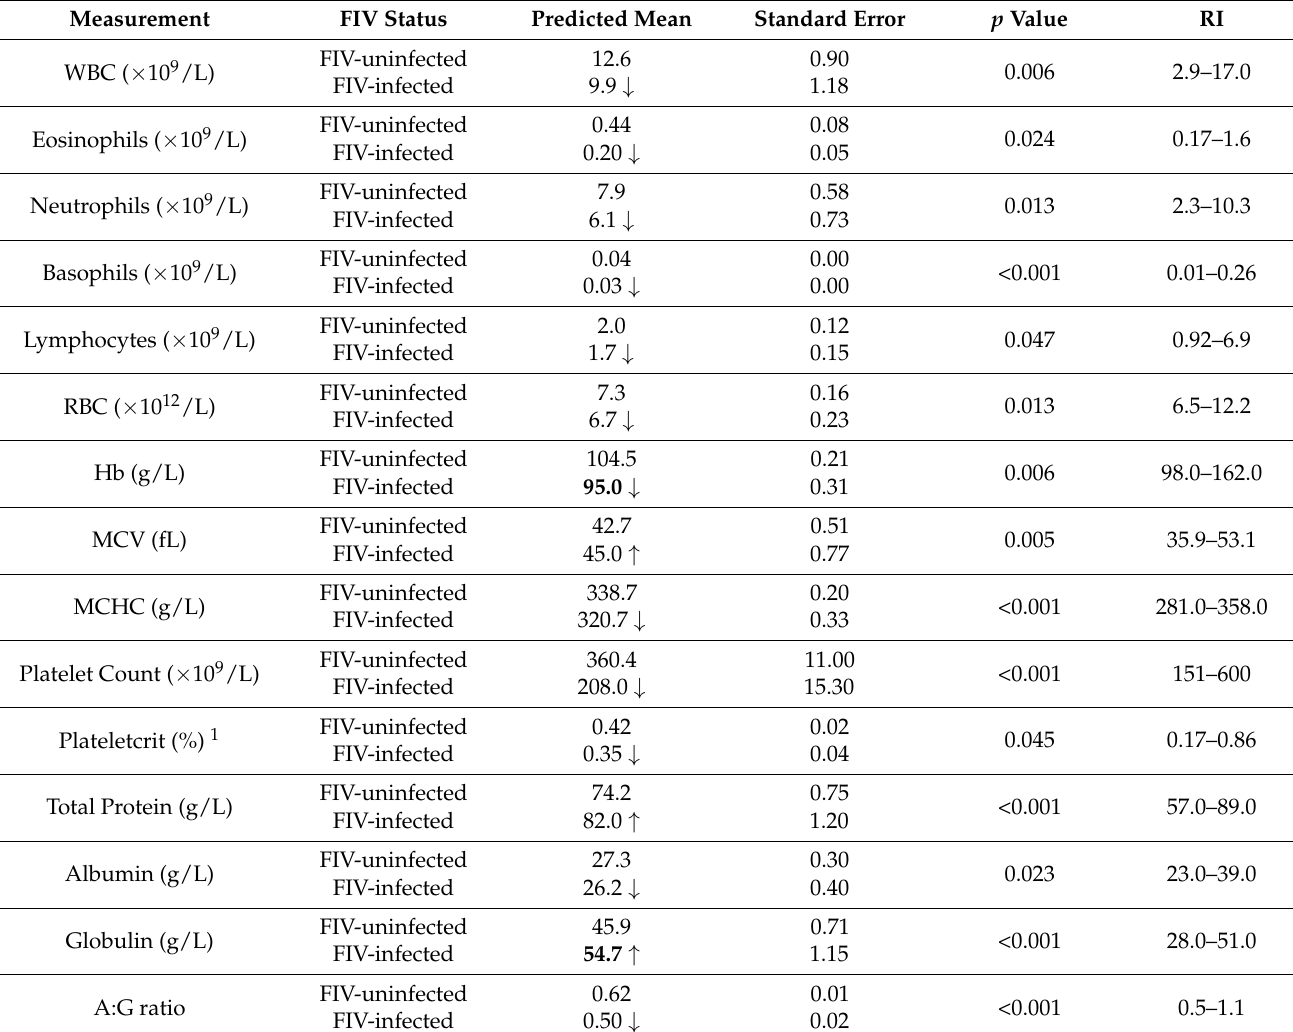
Table 4. Comparison of hematology and blood biochemistry results for cats in cohort 1 ( n = 525; in- house hematology and blood biochemistry testing). Only significant differences are shown (15 out of a total of 37 measurements analysed), with up ( ↑ ) and down ( ↓ ) arrows signifying significantly different mean values in FIV-infected cats compared to FIV-uninfected cats. Mean values for FIV-infected cats outside of the reference interval (RI) for normal healthy cats are annotated in bold. Only absolute WBC counts (i.e., not relative WBC counts) were evaluated. WBC = white blood cell count, RBC = red blood cell count, Hb = hemoglobin, MCV = mean corpuscular volume, MCHC = mean corpuscular hemoglobin concentration, A:G = albumin to globulin ratio, AST = aspartate aminotransferase, GGT = gamma glutamyl